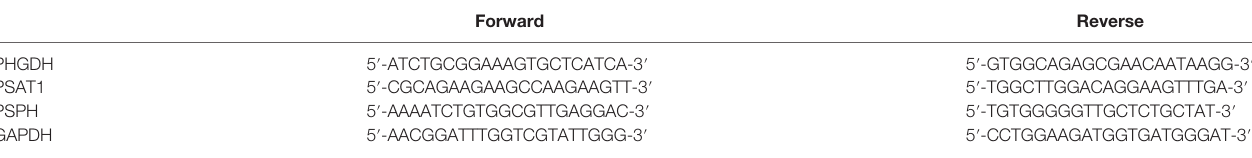
TABLE 1 | The qRT-PCR